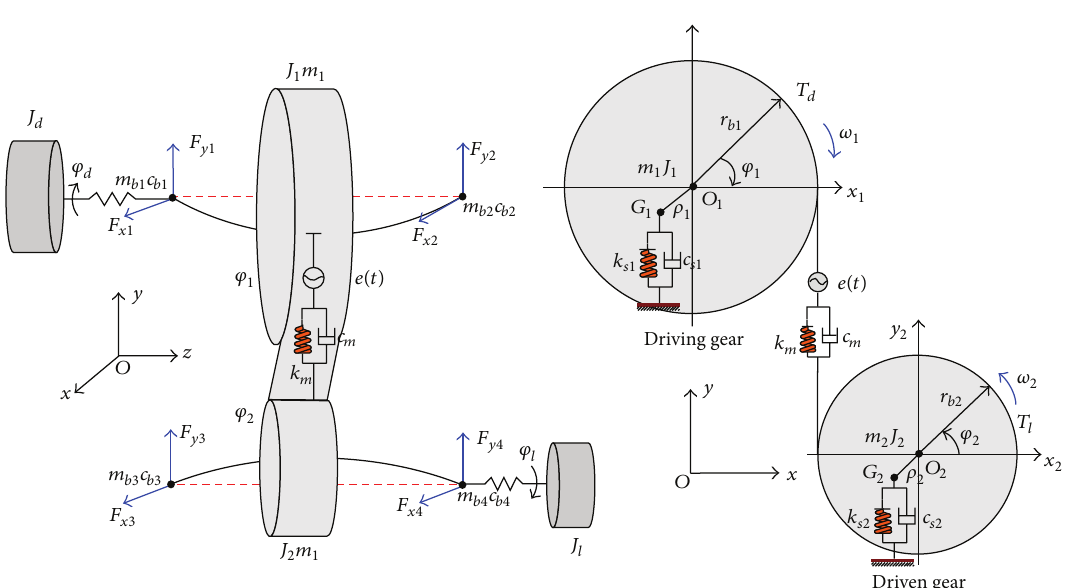
Figure 2: Dynamic model of spur gear rotor bearing